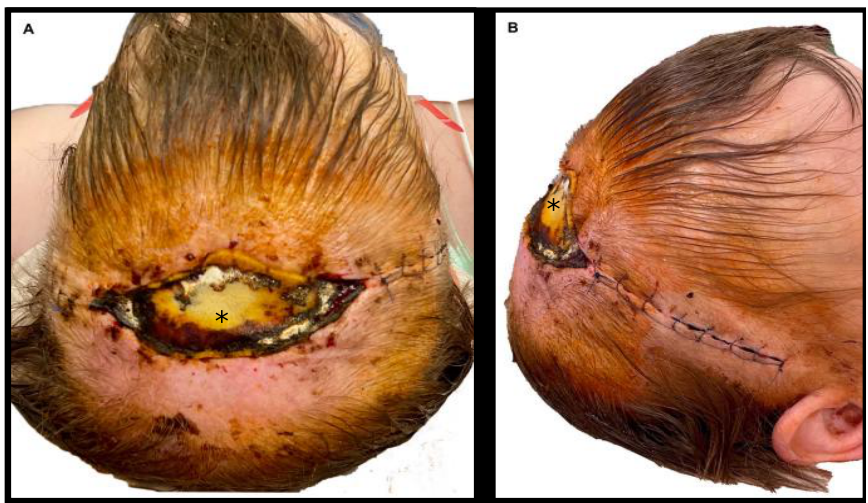
Figure 6. ( A,B ) Example of a patient with SSI and disrupted wound healing after coronal craniotomy with a straight incision due to recurrent meningioma. The asterisk marks a temporary wound dressing (EpiGARD ; Biovision GmbH, Ilmenau, Germany). The patient needed free flap tissue coverage in the course of therapy.